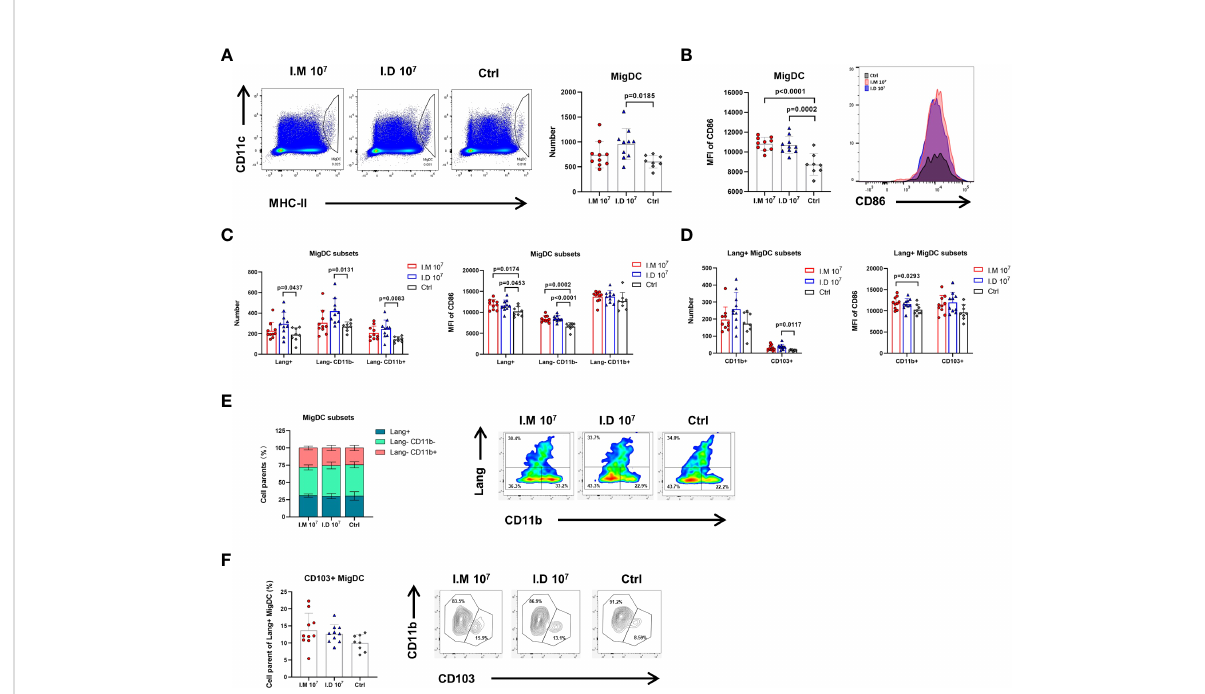
FIGURE 4 Intradermal injection modulated more migDCs but had no advantage in activation ability. Mice were killed on day 1 post-injection and popliteal, inguinal, axillary, and brachial LNs were harvested for further analysis. (A) Representative gates and numbers of migrate DCs in mice injected with different routes. (B) Representative median fl uorescence intensity of CD86 expression for migrate DCs population in mice injected with different routes. (C) Numbers and MFI of CD86 expression for migrate DCs subsets (Lang+, Lang-CD11b-, Lang-CD11b+) was compared. (D) Numbers and MFI of CD86 expression for Lang+ migrate DCs subsets (CD11b+ and CD103+) was compared. (E) The proportions of migrate DCs subsets were compared in mice with different routes. (F) The proportions of Lang+ migrate DCs subsets were compared in mice with different routes. Data is represented as genomic mean ± SD. Statistical signi fi cance was determined using one-way ANOVA followed by Tukey ’ s multiple comparisons